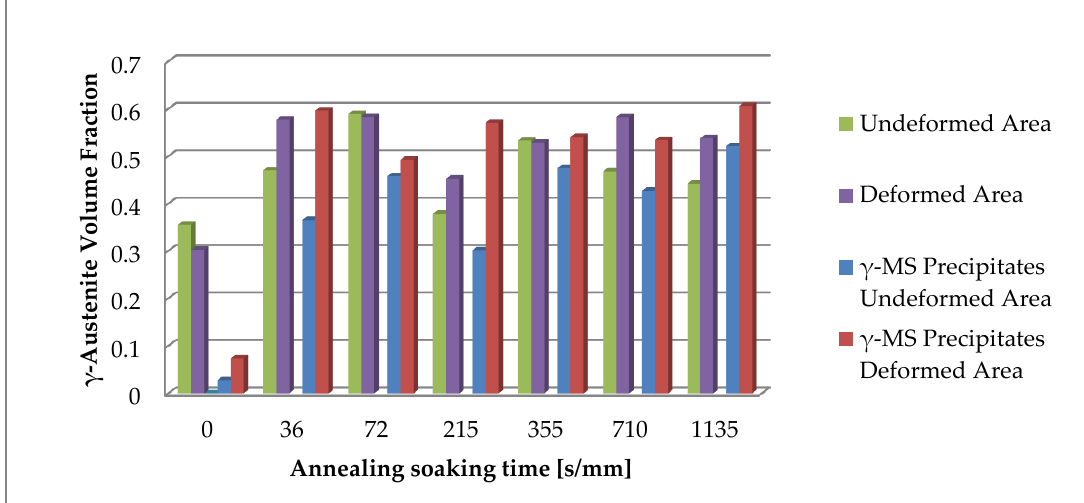
Figure 6. Comparison the γ-austenite phase ratio between the un-deformed and the deformed areas of the frature surface sections of the tensile samples. The increase in γ-austenite volume fraction between the two examinated ares, in particular regarding the Martensitic Shear precipitates, testifies to the occurrence of a strain-aided phase transformation phenomenon.